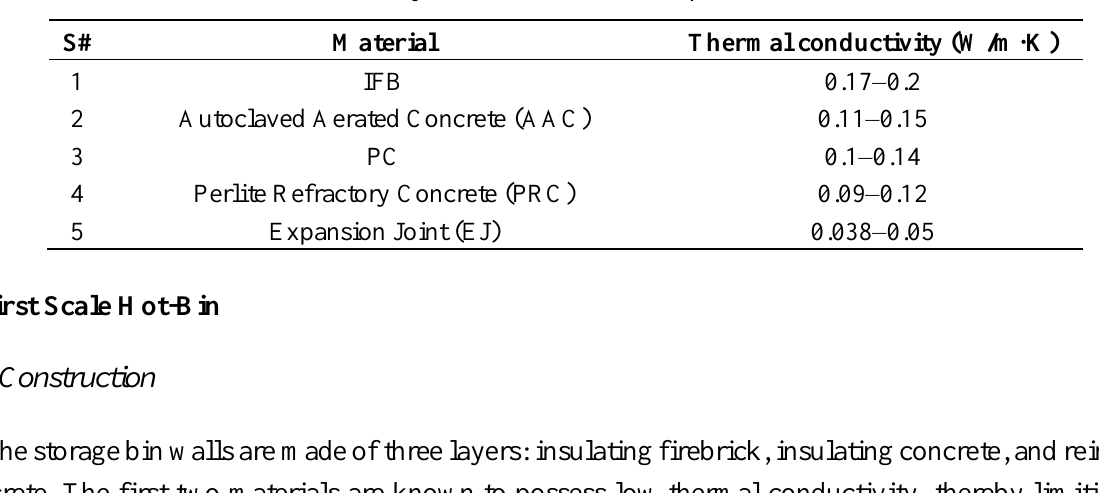
Table 2. Thermal conductivity measurements of the potential construction